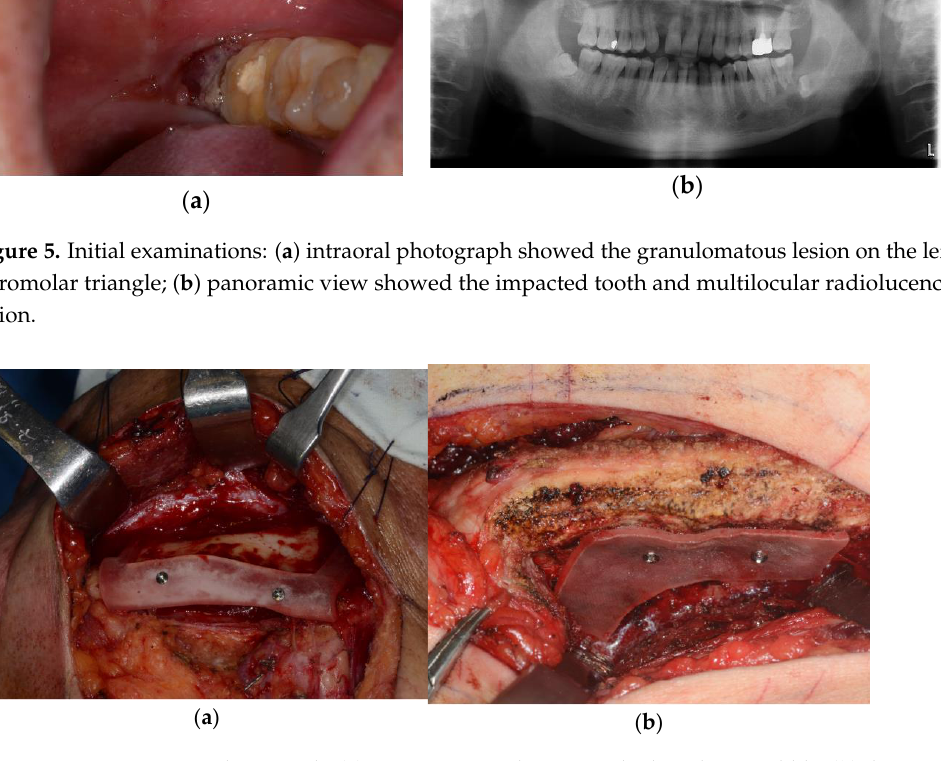
Figure 5. Initial examinations: ( a ) intraoral photograph showed the granulomatous lesion on the left retromolar triangle; ( b ) panoramic view showed the impacted tooth and multilocular radiolucency